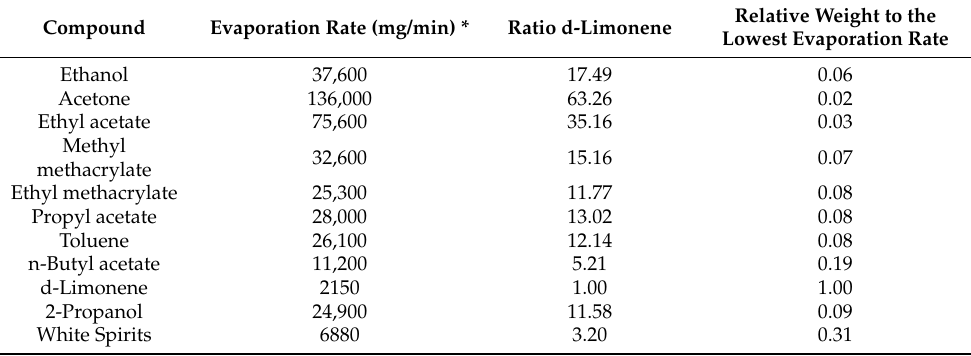
Table A1. Weighting factors of VOCs used to calculate adjusted TVOC